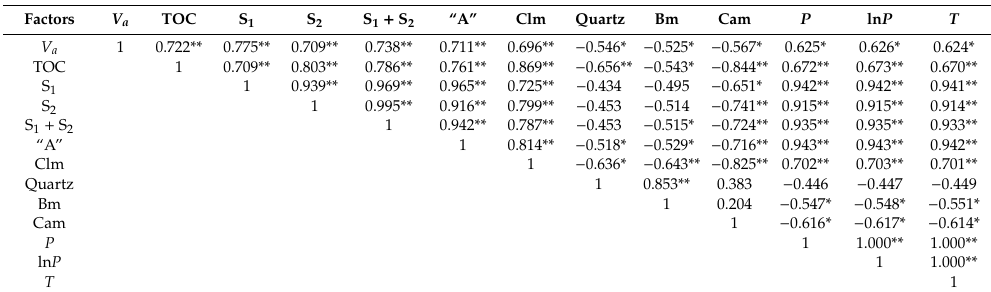
Table 2. Pearson correlation coe ffi cient ( R ) of V a and influence factors with statistical significance.